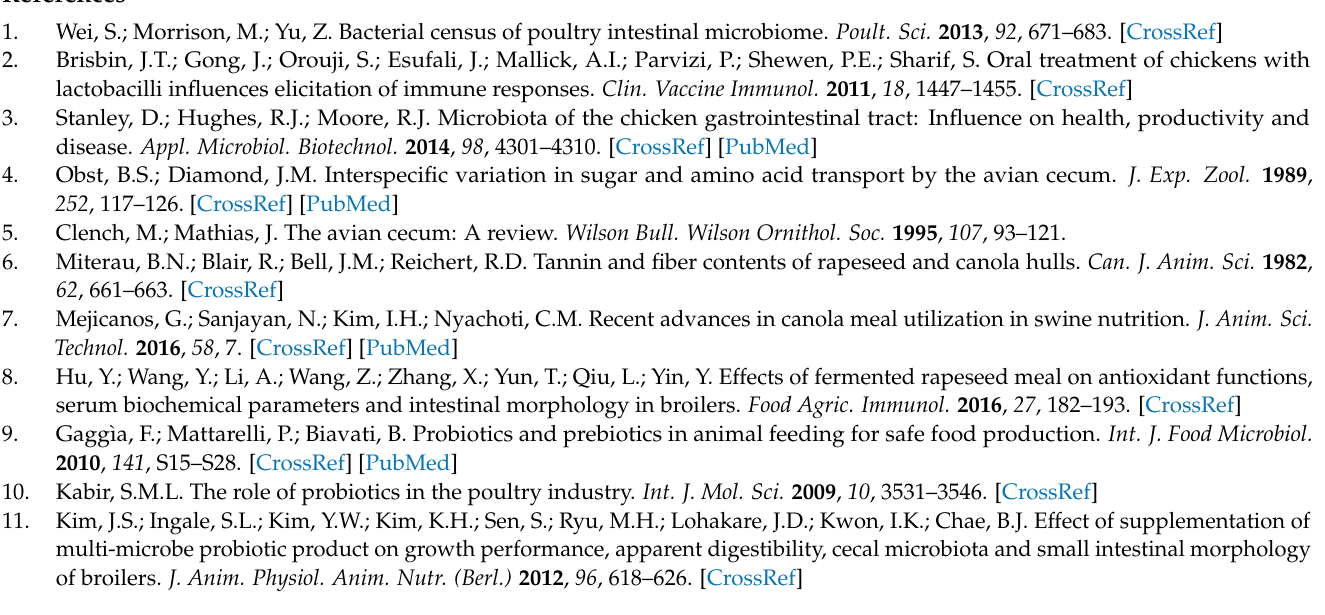
Table S1: Performance of broiler chickens used in the experiment. NC—negative control;